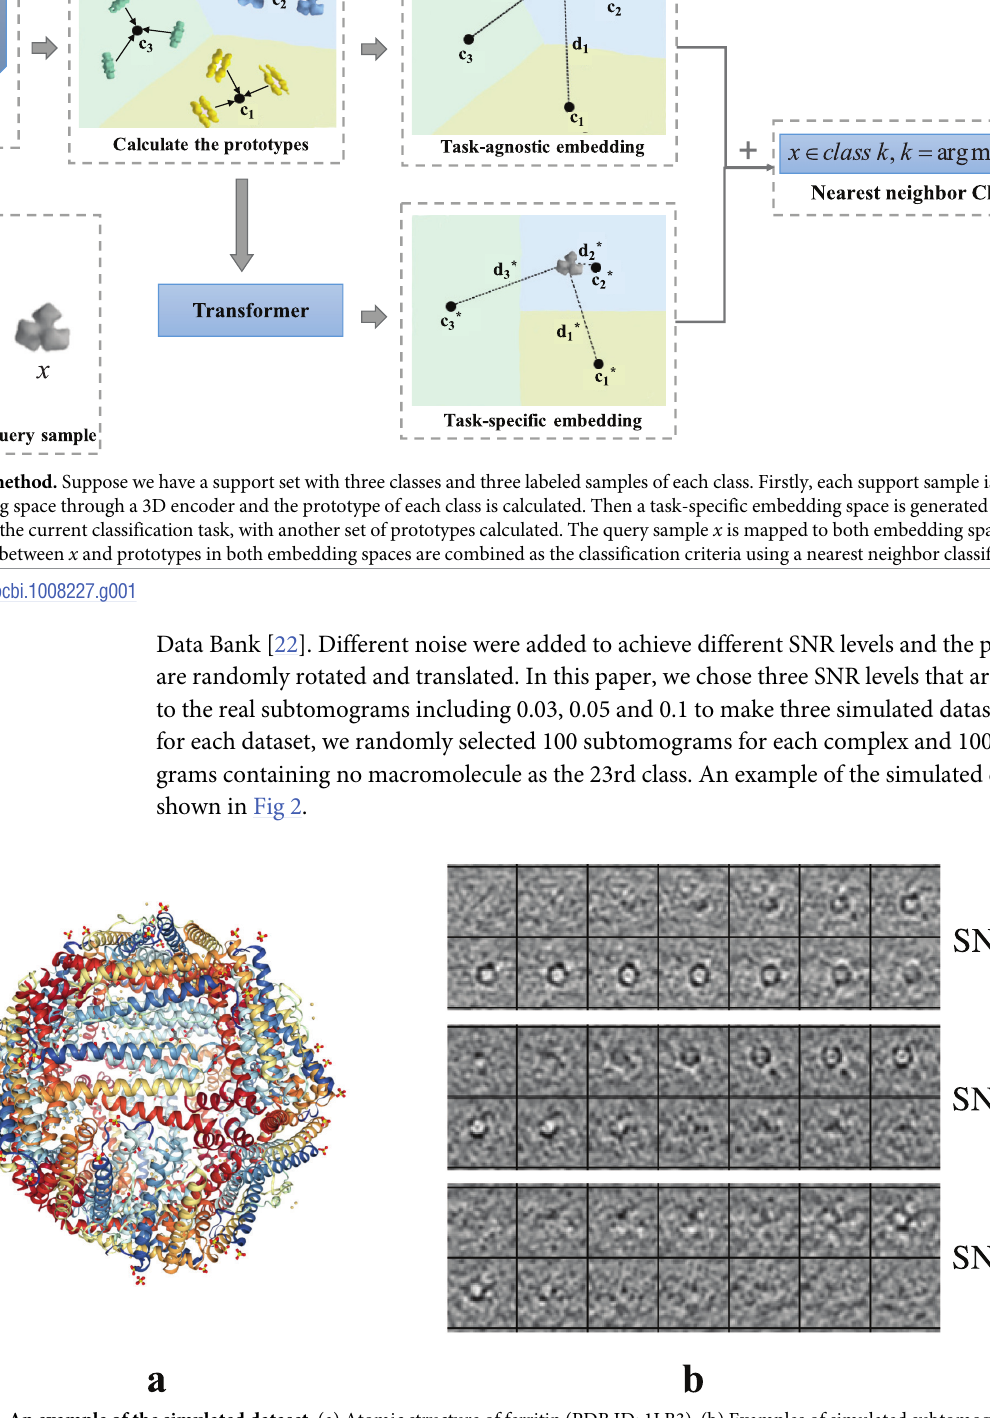
Fig 2. An example of the simulated dataset. (a) Atomic structure of ferritin (PDB ID: 1LB3). (b) Examples of simulated subtomograms containing ferritin macromolecule (PDB ID: 1LB3), represented by several slices of one subtomogram (40 × 40 × 40) in the simulated dataset with SNR = 0.1, 0.05 and